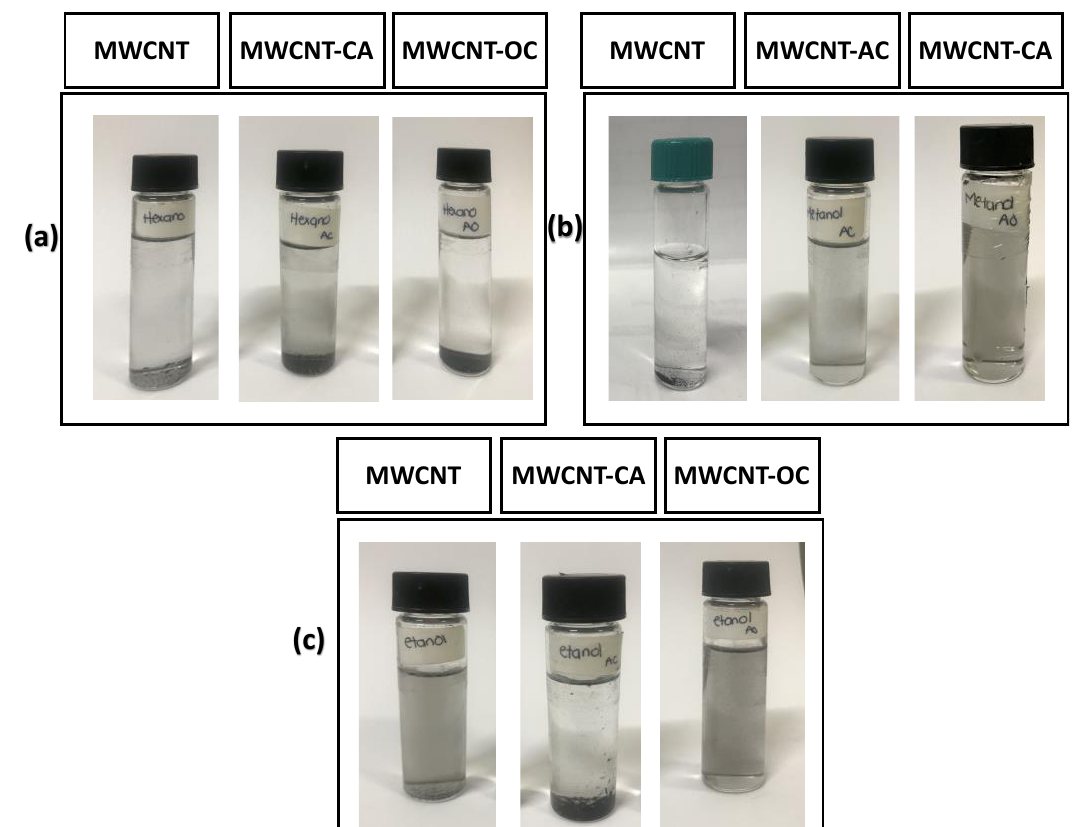
Figure 7. Dispersion of MWCNT, MWCNT-CA AND MWCNT-OA in different solvents ( a ) hexane, ( b ) methanol and ( c ) ethanol after 24 h.